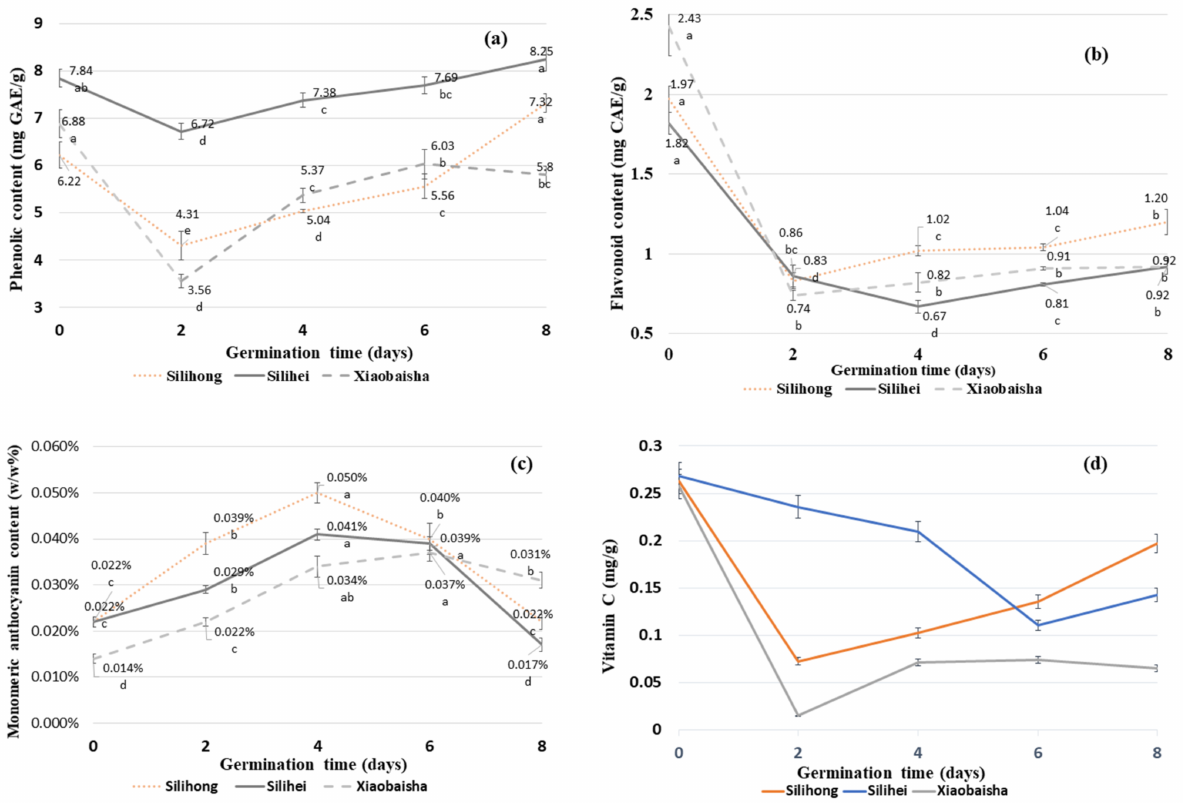
Figure 3. Kinetic changes ( a ) TPC, ( b ) TFC, ( c ) MAC, ( d ) vitamin C of peanut during germination. Data marked with the same letters were not statistically significant ( p >